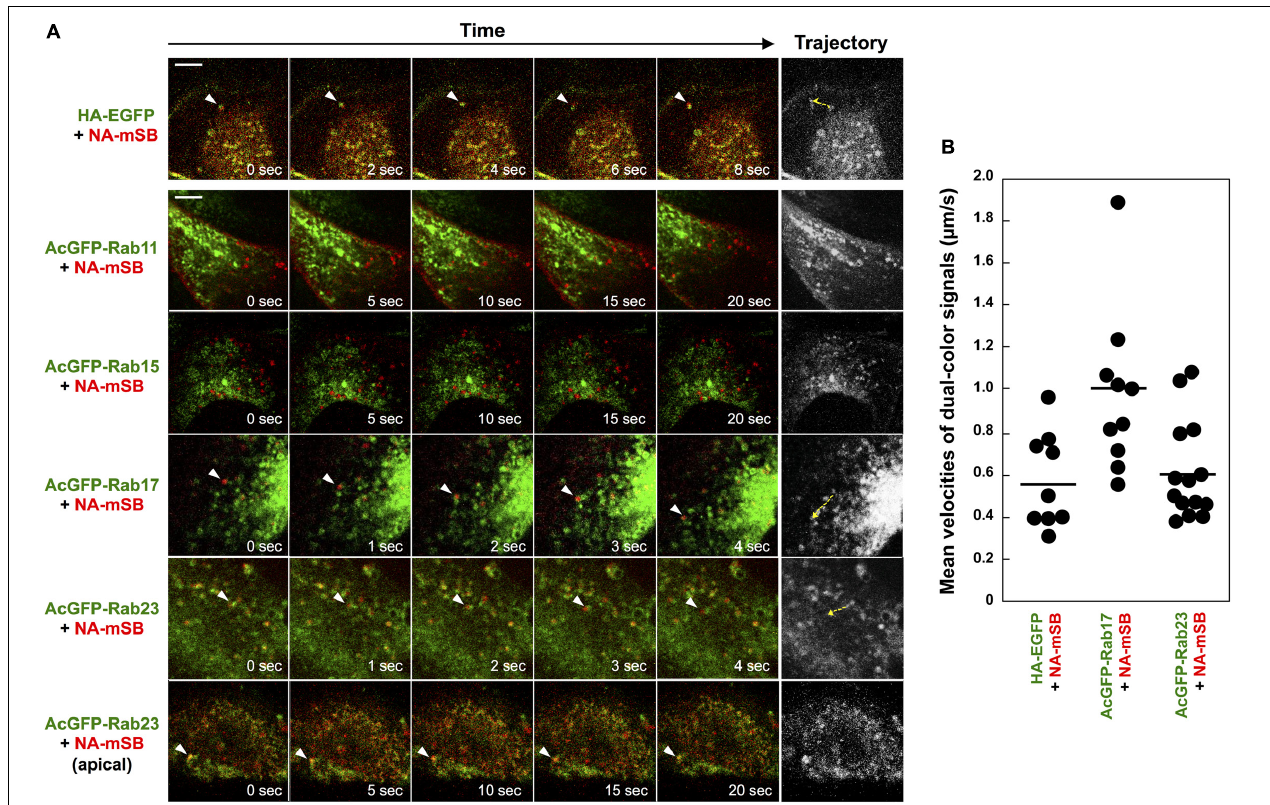
FIGURE 4 | Cotrafficking of HA and NA and cotransport of NA by Rab17- and Rab23-positive vesicles. (A) Live-cell imaging of AcGFP-Rab proteins and NA-mSB. Parental MDCK cells were transiently cotransfected with HA-EGFP and NA-mSB expression plasmids. MDCK cells stably expressing AcGFP-Rab11, Rab15, Rab17, and Rab23 were transfected with an NA-mSB expression plasmid. Live-cell imaging was performed at 12 hpt using a confocal microscope. Dual color images were sequentially acquired at 1-s intervals and were processed by using ImageJ software. Sequential merged images were shown in Supplementary Movie S1 . Time-split 5 images in each movie were shown. Arrowheads indicate cotrafficking signals. Examples of cotrafficking signals were shown as trajectories in most right panels (yellow dashed). Scale bar, 10 µ m. (B) Velocities of NA-mSB cotransported with HA-EGFP, AcGFP-Rab17, or AcGFP-Rab23. Each dot indicates a vesicle analyzed. A horizontal line shows the mean velocity of analyzed vesicles in each